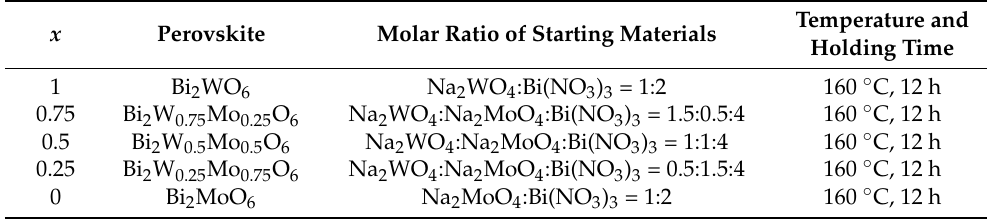
Table 1. Hydrothermal synthesis of Bi 2 W x Mo 1 − x O 6 perovskites. x Perovskite Molar Ratio of Starting Materials